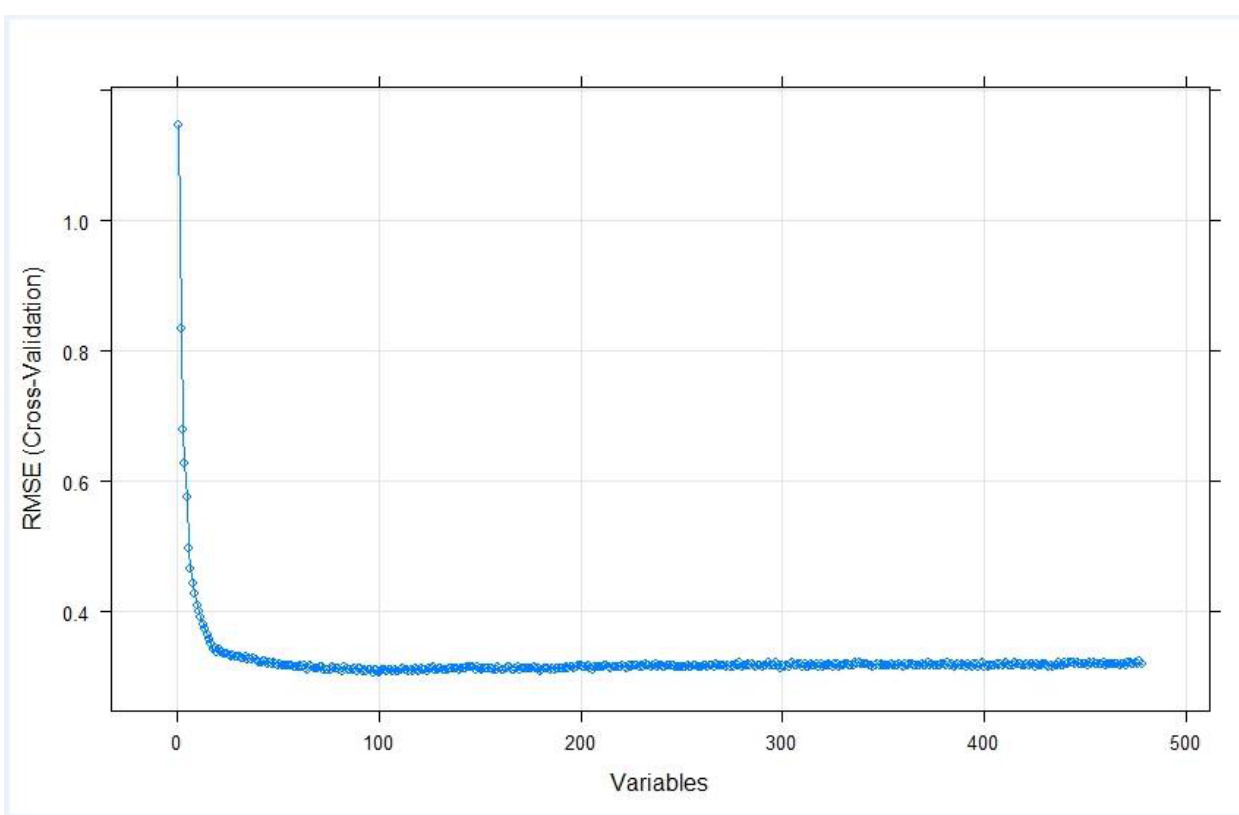
Figure 3. Importance of Variables Using Random Forest Recursive Feature Elimination Method.